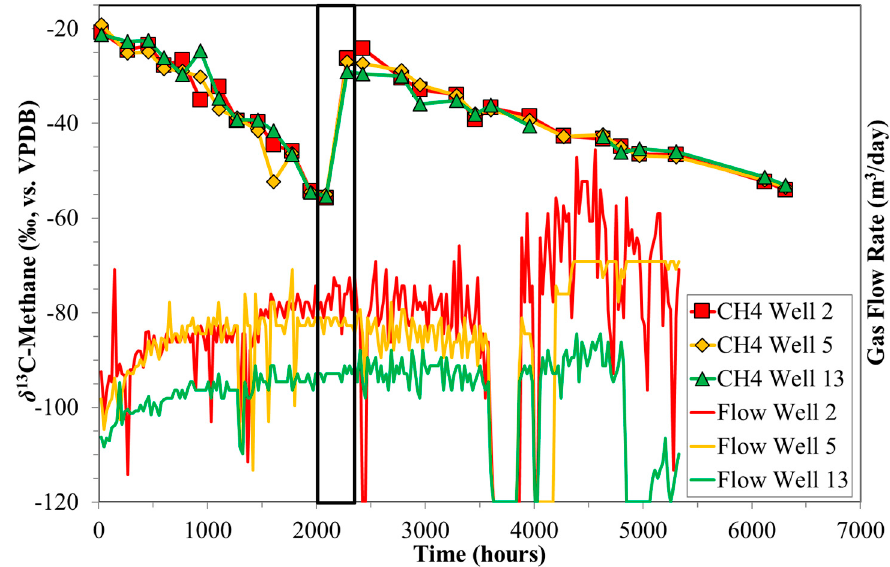
Figure 9. Time series of δ 13 C-CH 4 versus production time for sample set P3. Also shown are the production profiles for the three wells comprising P3. The 0 h value corresponds to the first samples collected. No change in production values correlating with the change in δ 13 C-CH 4 between 2088 and 2280 h (black box) can be observed.